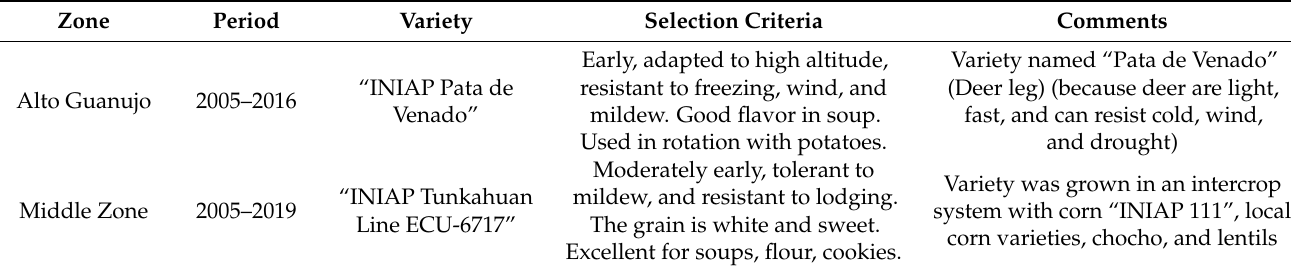
Table 2. Results of the participatory research on quinoa at two agronomic zones in the province of Bolivar, Ecuador. Zone Period Variety Selection Criteria Comments Variety named “Pata de Venado” Early, adapted to high altitude, (Deer leg) (because deer are light, resistant to freezing, wind, and “INIAP Pata de Alto Guanujo 2005–2016 fast, and can resist cold, wind, mildew. Good flavor in soup. Venado” and drought) Used in rotation with potatoes. Middle